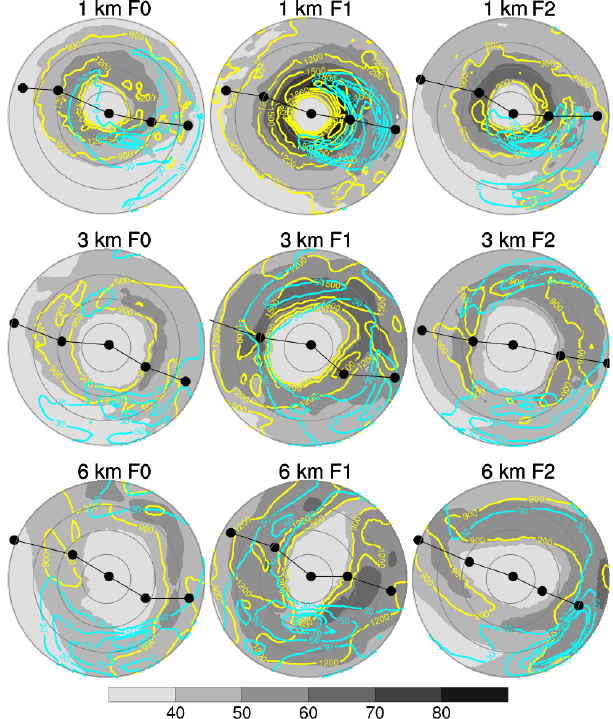
Figure 6. Horizontal distributions for wind speed at 10m height (shaded; ms − 1 ), surface latent heat flux (yellow contours; Wm − 2 ), and total rainfall (cyan contours; mmh − 1 ) at 71h for all experi- ments. In all the experiments, the center location of the simulated typhoon at 71h is at the nearest or the second nearest location to the best-track location at 18:00UTC on 7 November 2013. The dis- tributions for experiment F0 of 3km resolution are the same as in Fig. 5 but slightly zoom in on a circle of radius 80km; range rings are shown at radii of 20, 40, 60, and 80km. Other symbols are shown as in Fig.